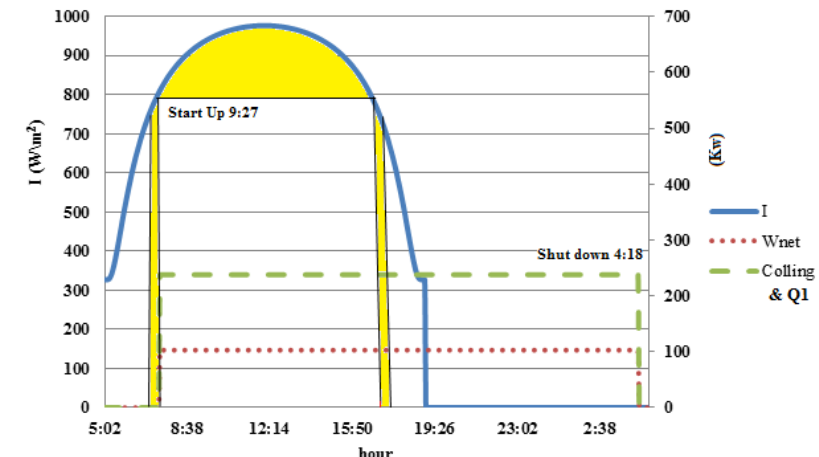
Figure 9. Functioning period of solar cycle for CCHP of the residential complex on the longest day of the year